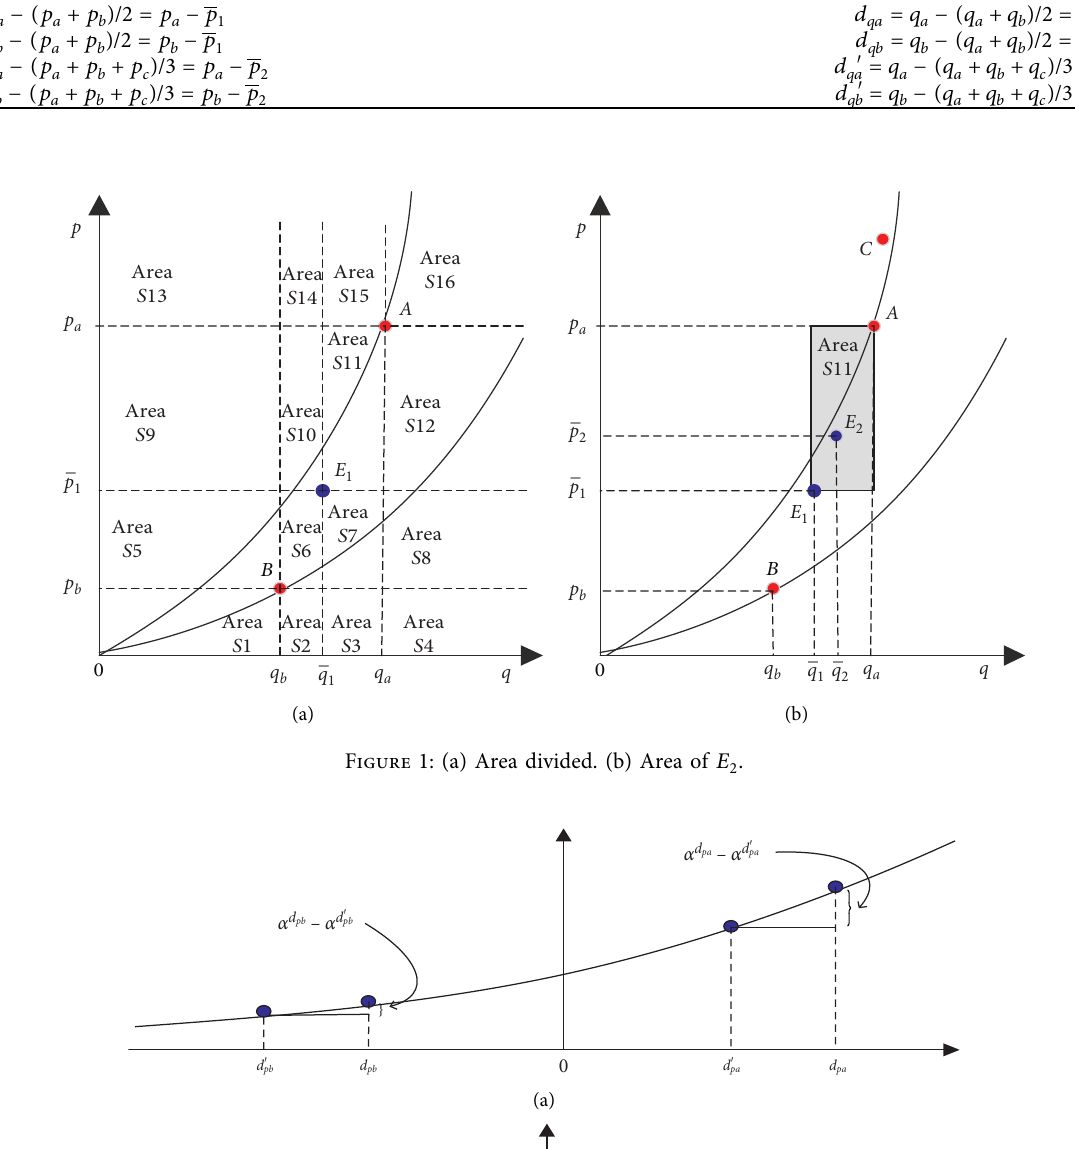
Figure 3: Charts of price sensitivity and quality